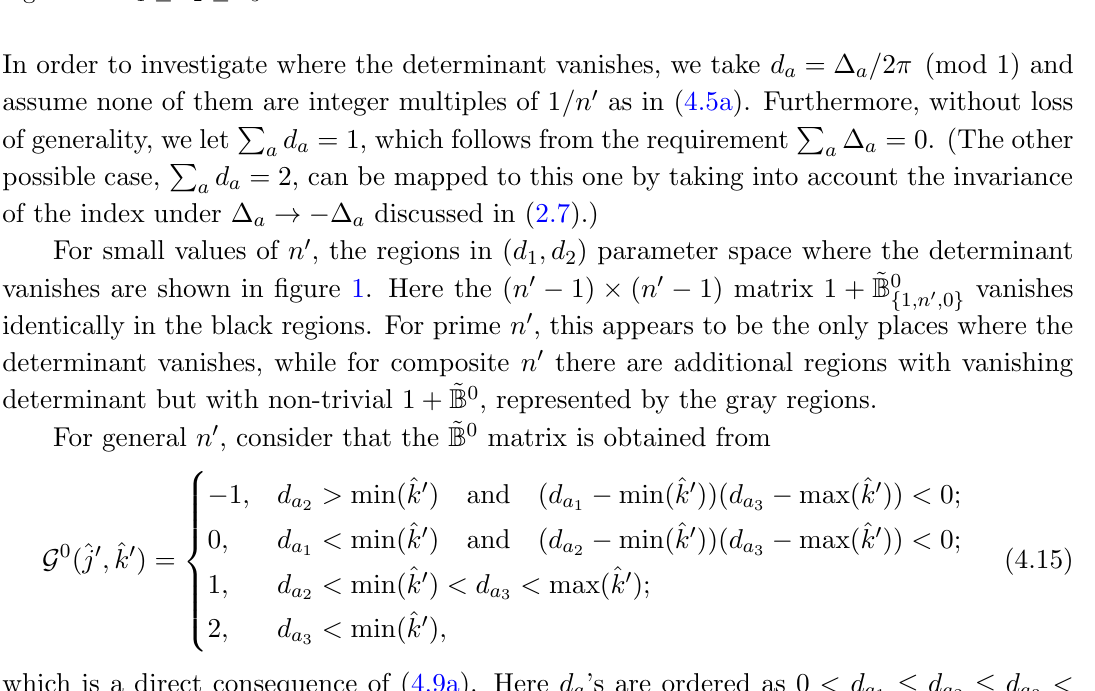
Figure 1 . Regions of vanishing determinant for n 0 = 2 ; : : : ; 7. The black regions correspond to 1 + ~ B 0 = 0, while the gray regions correspond to non-trivial 1+ ~ B 0 , but still with vanishing determinant. The determinant evaluates to n 0 2 in the unshaded regions. The yellow triange corresponds to the region 0 < d 1 (cid:20) d 2 (cid:20) d 3 <